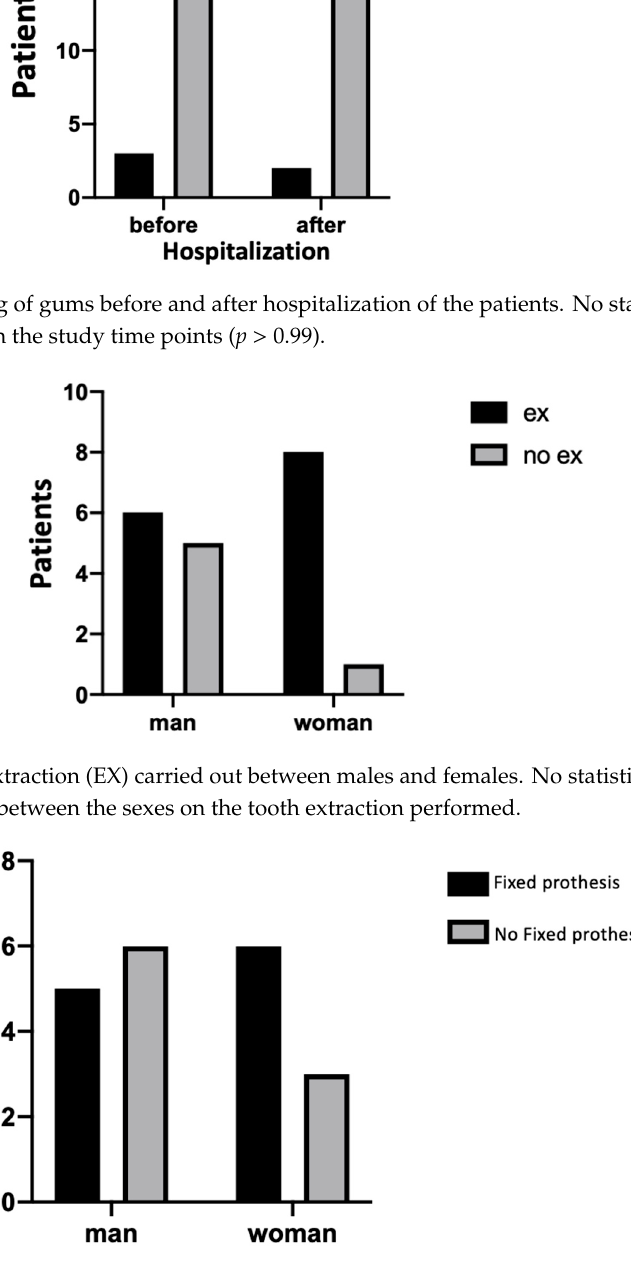
Figure A5. Di ff erence between fixed-prosthesis wearers between males and females. No statistical Figure A5. Difference between fixed-prosthesis wearers between males and females. No statistical significance ( p = 0.40) was shown between the significance ( p = 0.40) was shown between the sexes. Figure A5. Difference between fixed-prosthesis wearers between males and females. No statistical significance ( p = 0.40) was shown between the sexes. Figure A5. Difference between fixed-prosthesis wearers between males and females. No statistical significance ( p = 0.40) was shown between the sexes.